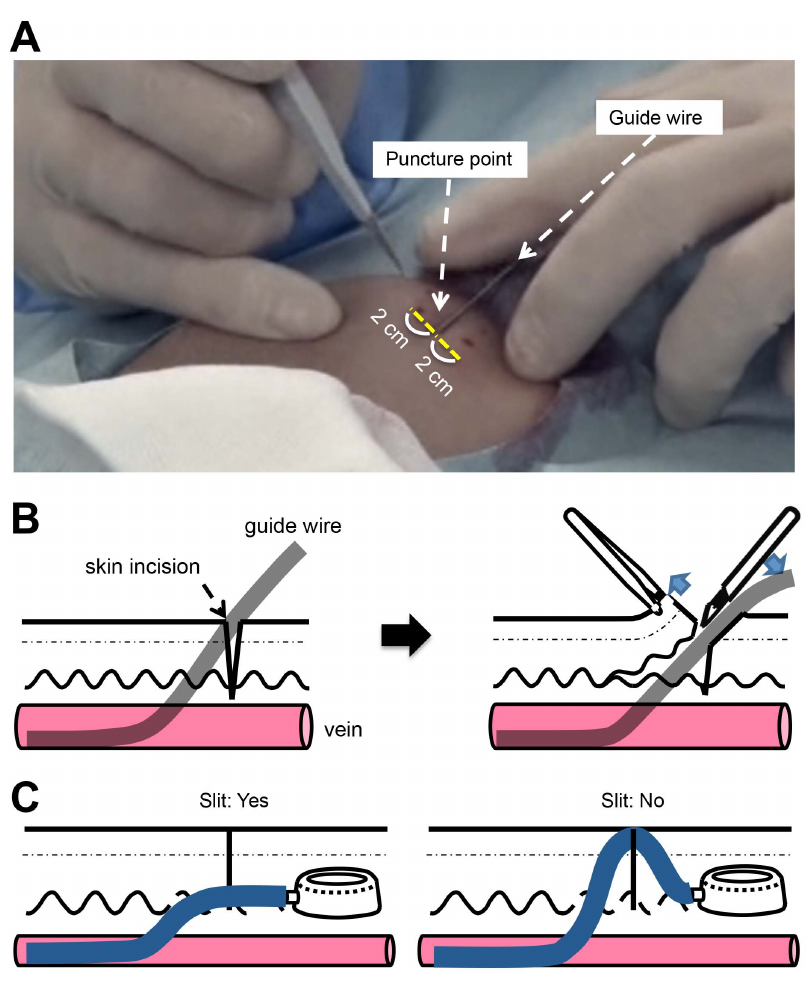
Figure 6. Port Implantation. ( A ) Skin incision. A scalpel should be used to make a skin incision from 2 cm to the right to 2 cm to the left of the puncture point. This incision should be used later as the entrance for making a subcutaneous pocket with a forceps. ( B ) Making a slit between the skin and wire. The connective tissues between the skin and wire should be cut with a scalpel to make a slit a few millimeters long over the wire in the puncture point. ( C ) The purpose of a slit. Without this step, the catheter route will be shallower from the skin surface; subsequently, the risk of catheter exteriorization will increase.